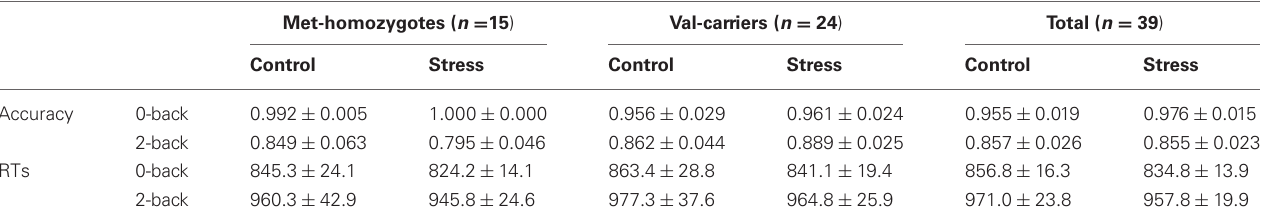
Table 3 | Averaged (mean ± SE) accuracy and reaction times for 0- and 2-back working memory ( n = 39).